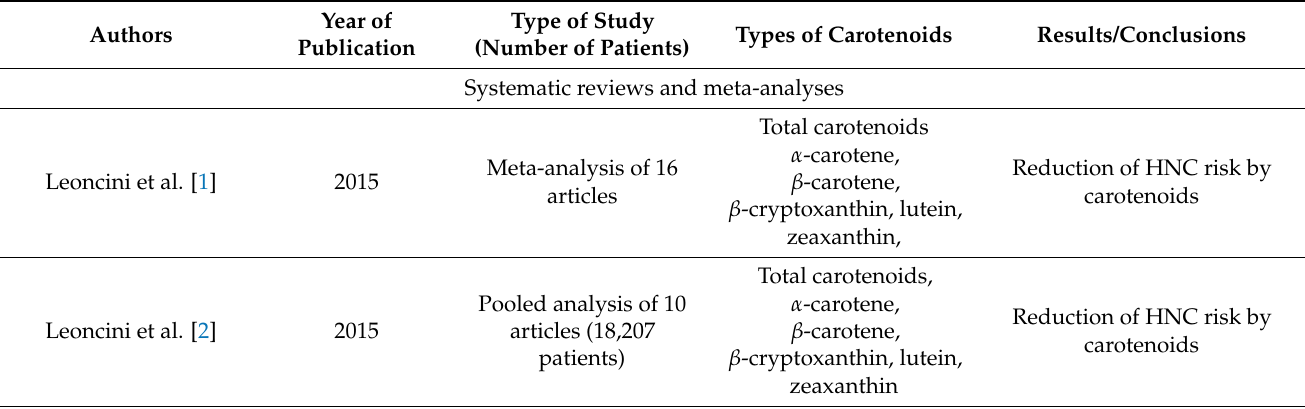
Table 1. Summary of the most important studies on the relationship between carotenoids and head and neck